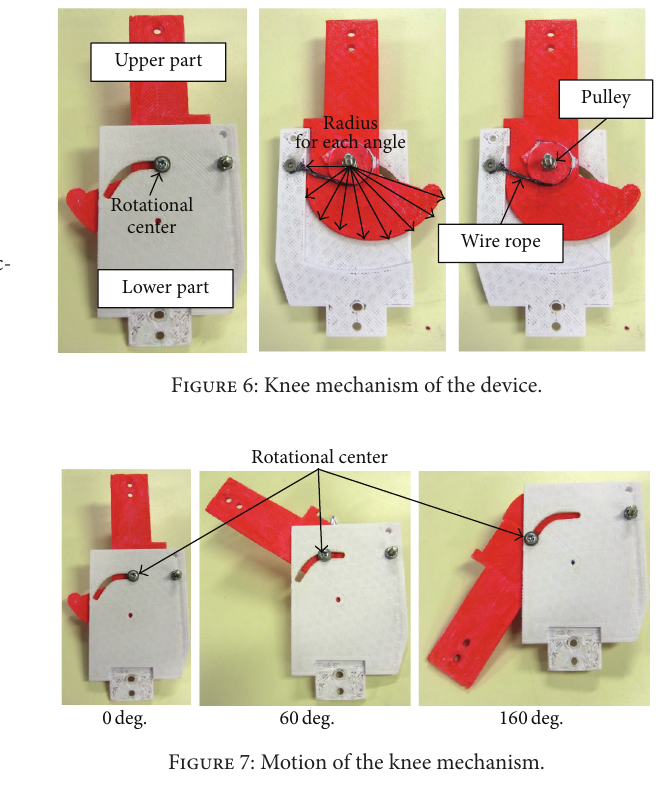
Figure 5: Compression rate versus compression force of the pneu- matic actuator.